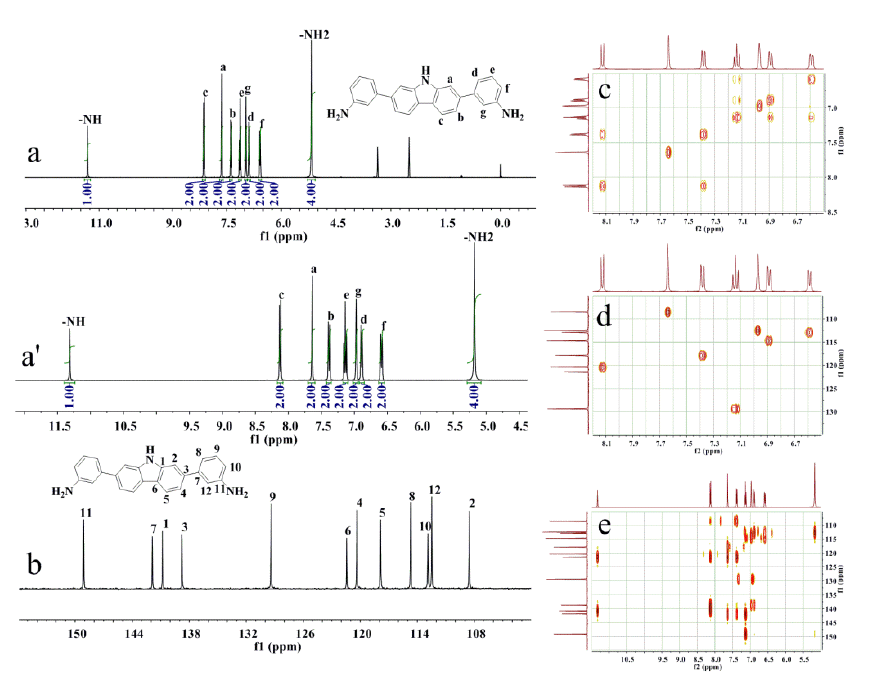
Figure 2. 1 H NMR in the range of 0~13 ( a ), 1 H NMR in the range of 4.5 ~ 11.5 ( a’ ), 13 C NMR ( b ), H-H COSY ( c ), C-H QC ( d ), and C-H BC ( e ) spectra of M-2,7-CPDA in DMSO- d 6 .